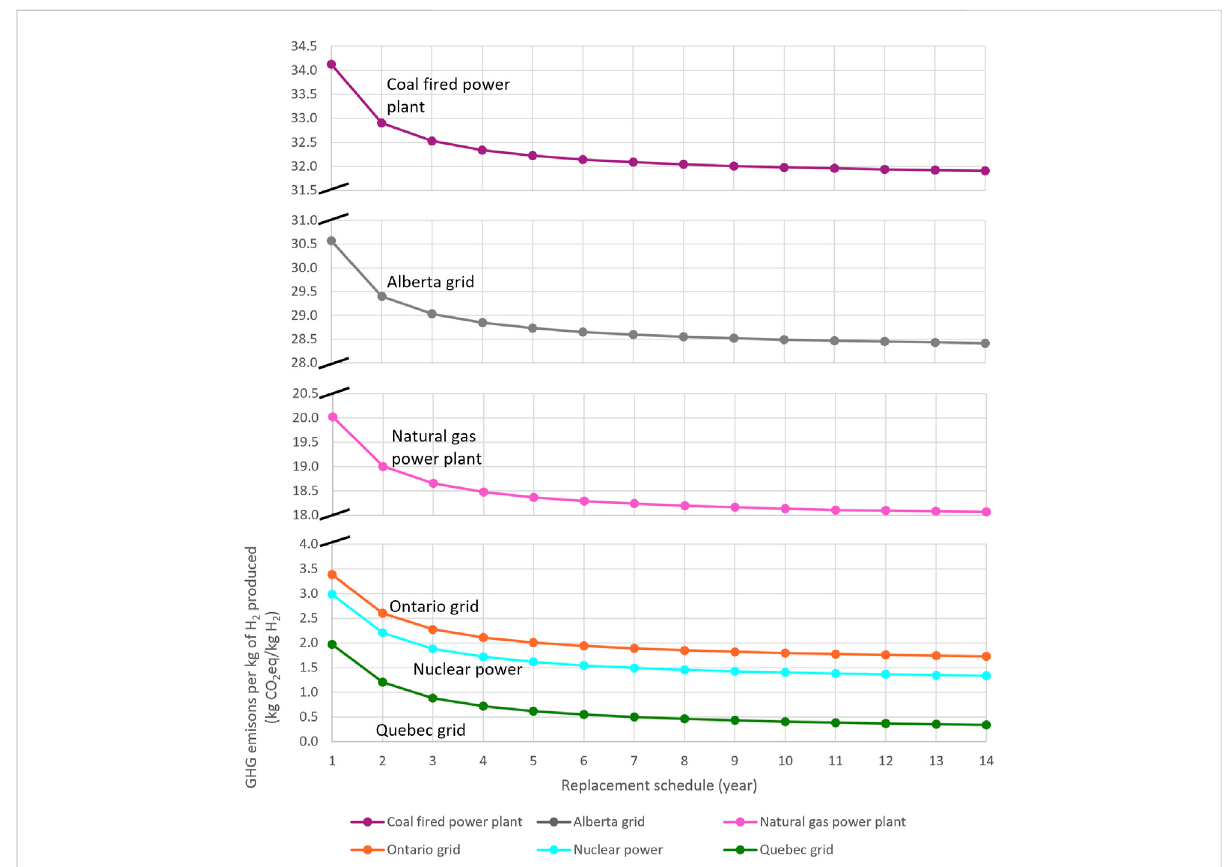
FIGURE 10 Life cycle GHG emissions per kg of hydrogen produced by SOECs with various power